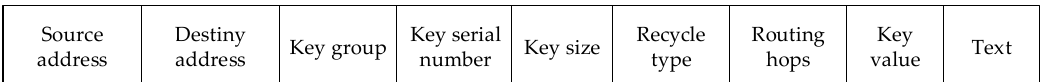
Figure 7. QKR mechanism and three recycling methods: a) partial recycling, b) all recycling, and c) mixed recycling.